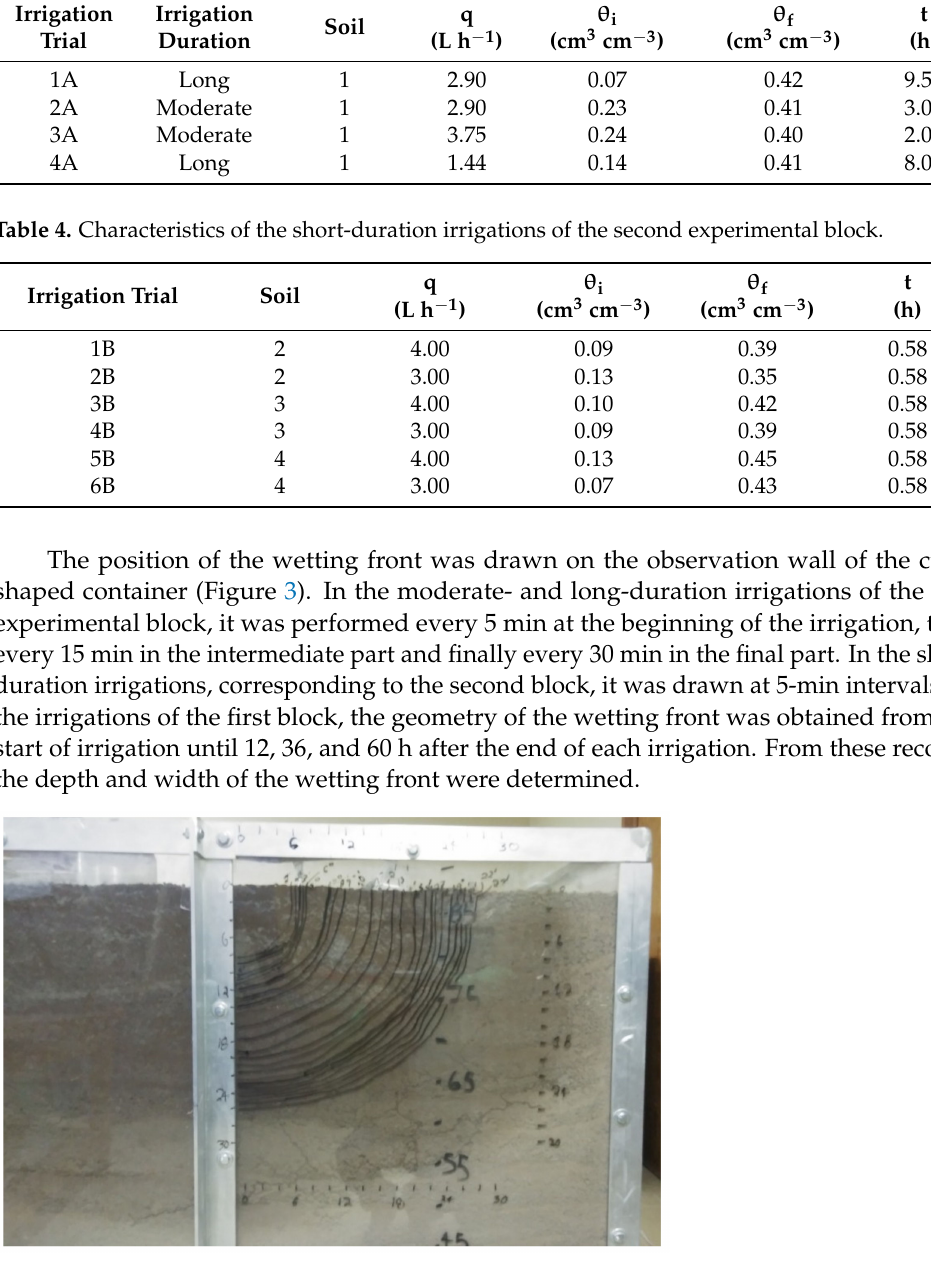
Figure 3. Marking of the wetting front on the observation wall of the soil